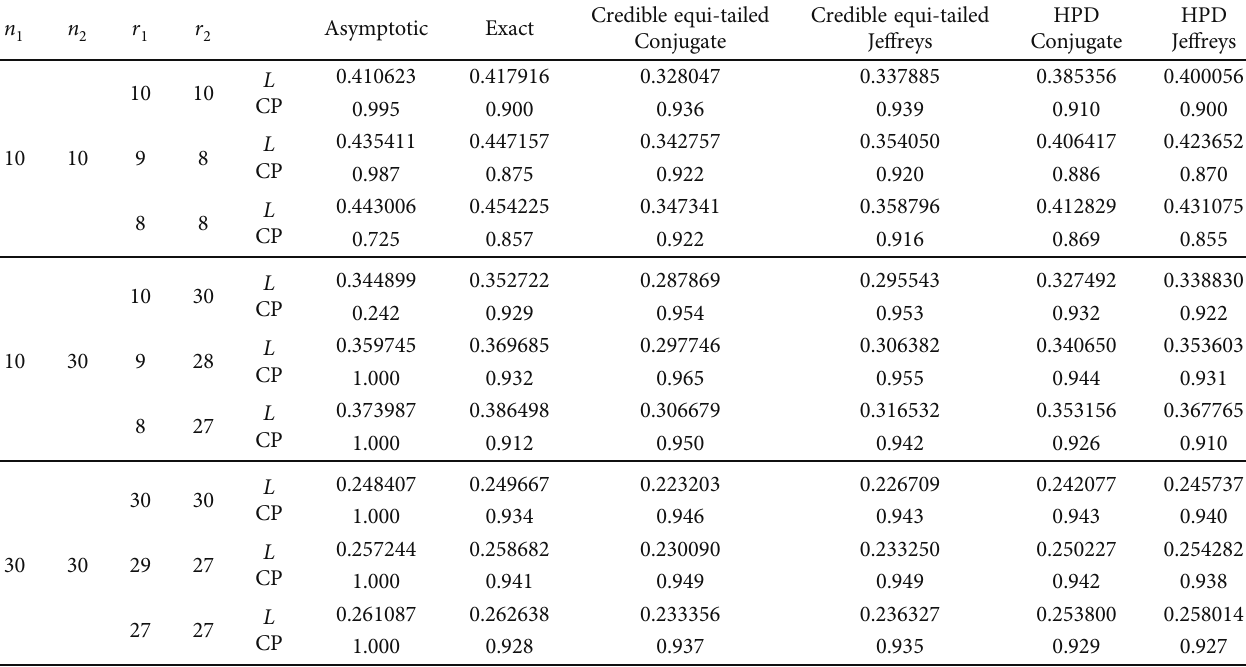
= 1, β = 1 and γ = 1 1 2